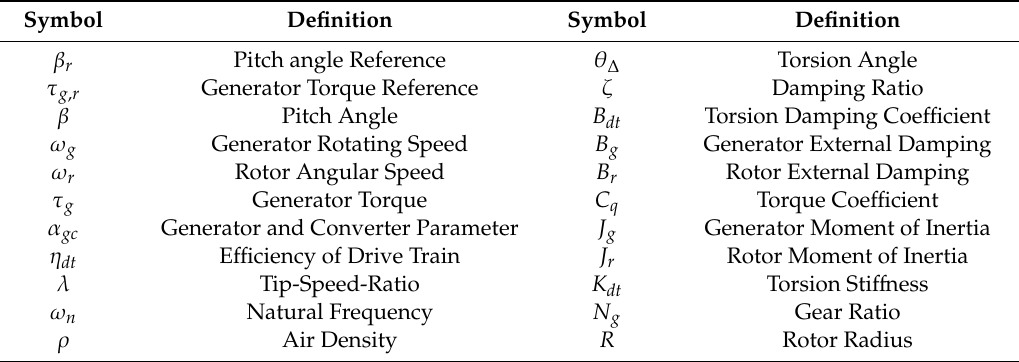
Figure 1. A schematic diagram of the wind turbine system.